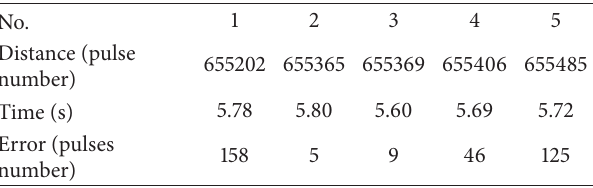
Table 2: Experiment data of operating 160